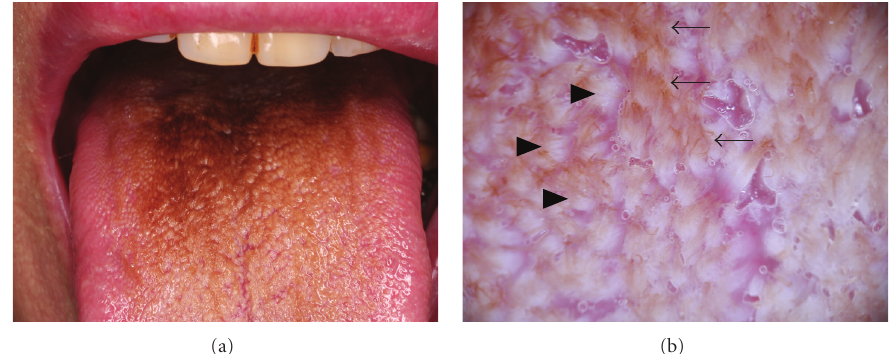
Figure 1: (a) Black hairy tongue on the dorsum of the tongue (Case 1). (b) Brownish hair-like elongation of filiform papillae ( → ) and whitish lingual papillae ( (cid:2) ) (Case 1).